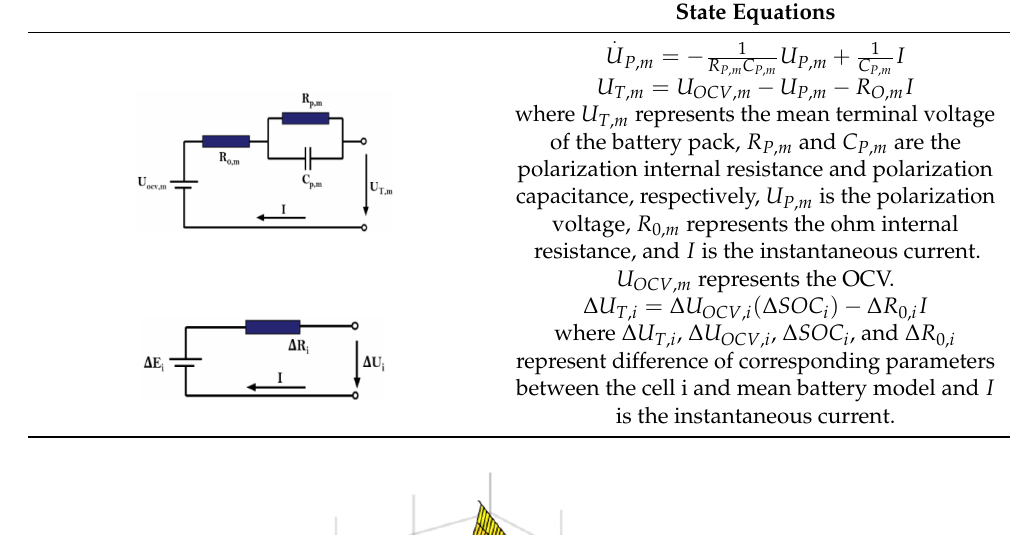
Figure 2. SOC–Temperature–OCV three-dimensional schematic of the NMC batteries.